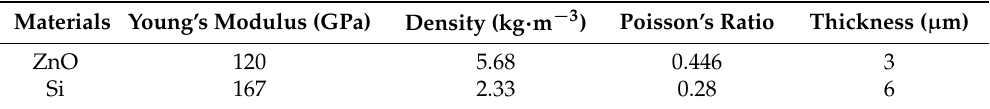
Table 1. Materials properties and thickness used in FEM simulation.